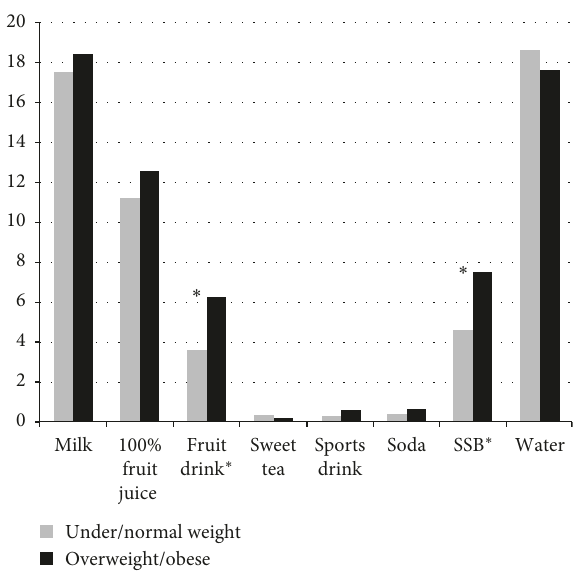
Figure 2: Daily average beverage intake in ounces, by weight status.